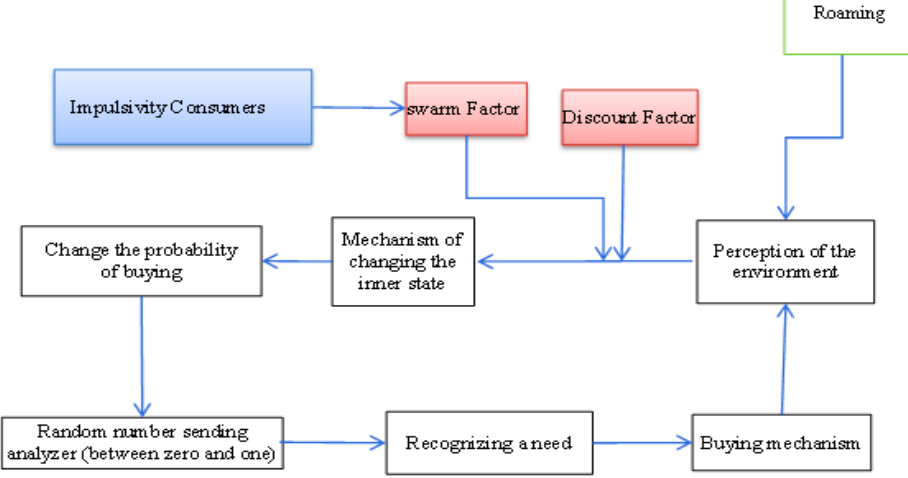
Fig. 5. Conceptual model of research (source: research